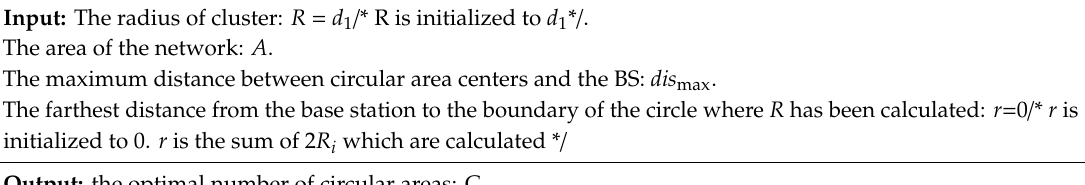
Algorithm 1: The calculation process of optimal circular area number C